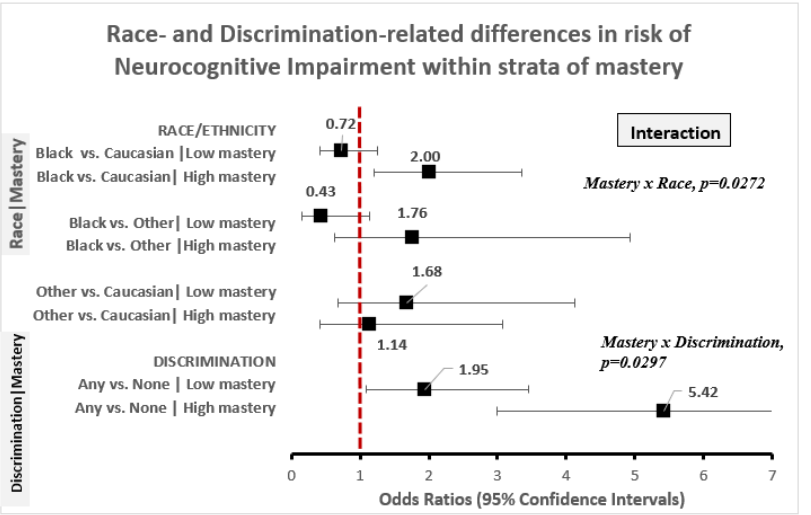
Figure 1. Race and discrimination-related differences in risk of Neurocognitive impairment within strata of mastery. 3.2. High Toxic Stress Is Associated with Higher NI; Relationship Varies by Mastery Level and Age The odds of NI, was elevated for adults that reported high vs. low levels of chronic stress (OR = 1.88, 95% CI: 1.43–2.49), the experience of one or more vs. no everyday discrimination (OR = 4.05, 95% CI: 2.61–6.30) and having high vs. low perceived